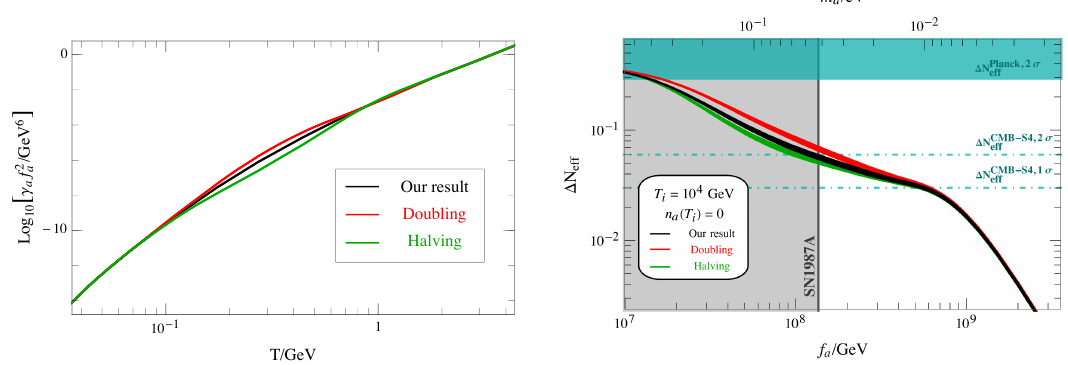
Figure 15 . Left panel: production rate for the KSVZ axion employed in our paper (black), and factor of 2 enhancement (red) or suppression (green) around the QCDPT. Right panel: predictions for ∆ N for the three different eff